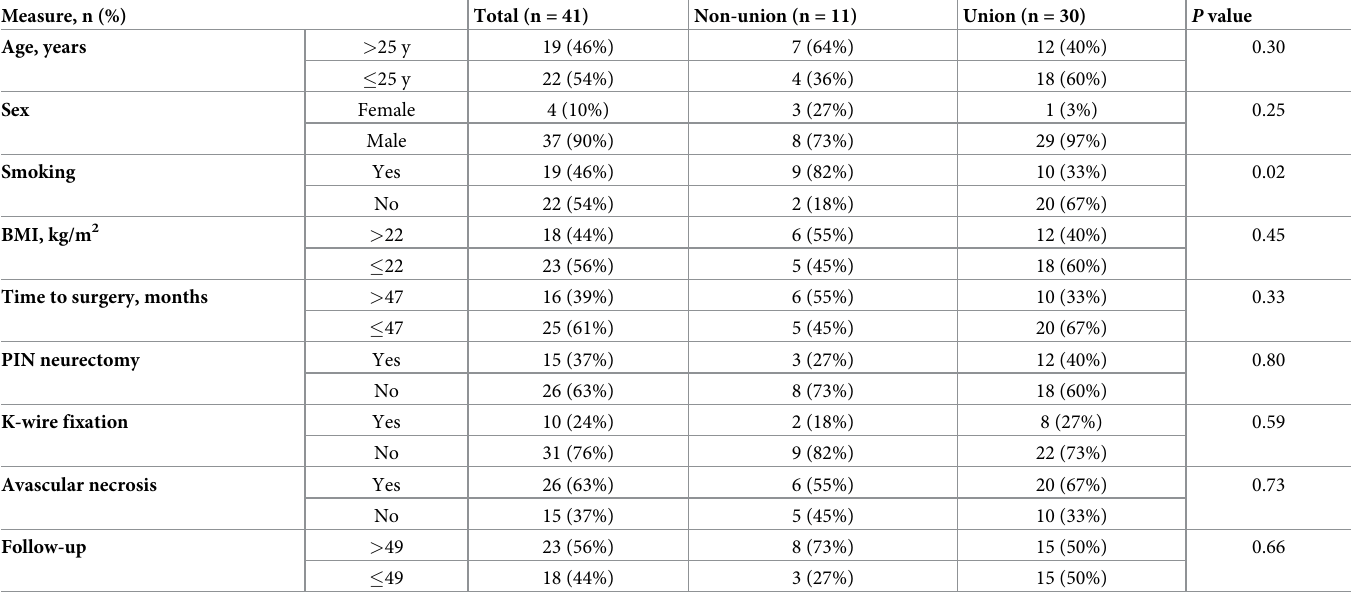
Table 2. Clinical characteristics of patients and their association with postoperative